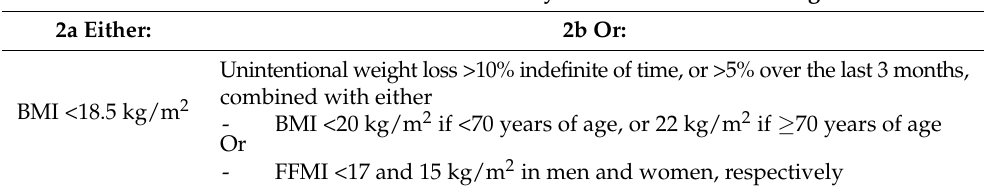
Table 1. Diagnostic criteria for malnutrition according to the European Society of Clinical Nutrition and Metabolism